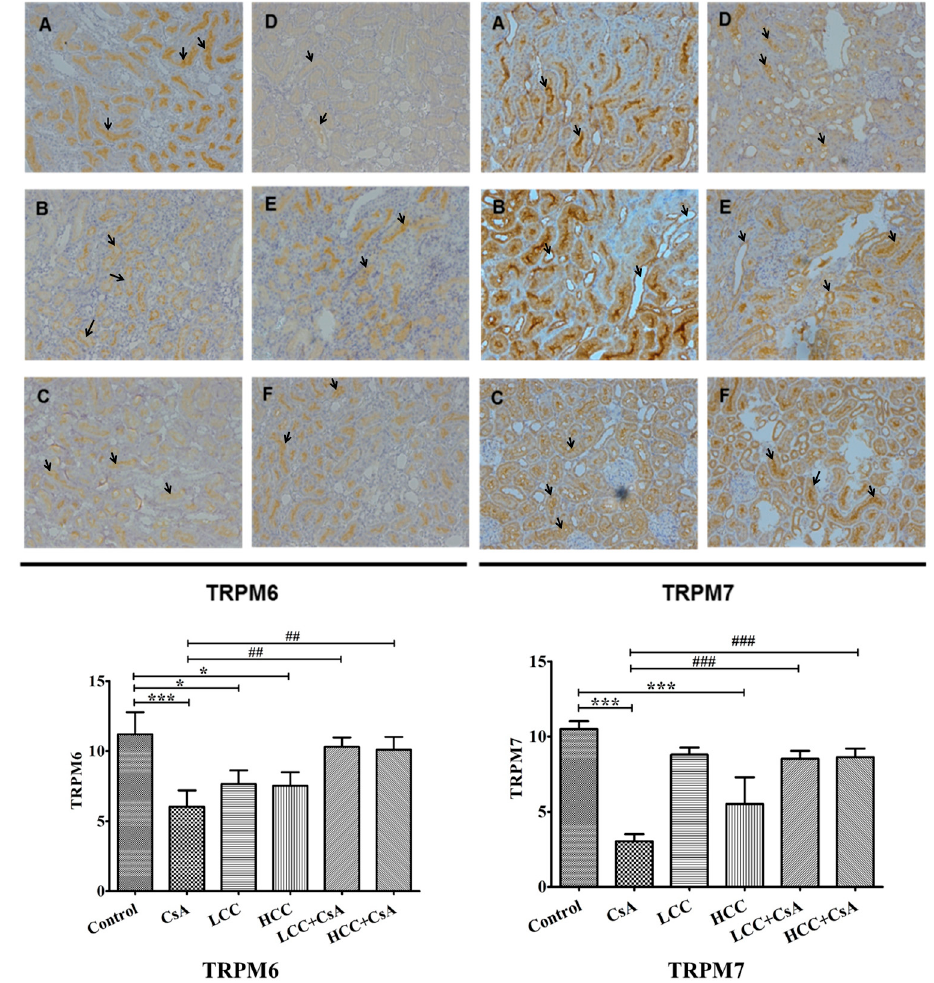
Figure 5. Representative immunohistochemistry (top panel) and quantitative analysis (bottom panel) of the levels of transient receptor potential melastatin 6 (TRPM6) and TRPM7 in rats treated with CCM and CsA. Arrows indicate the cells with the differences of TRPM6 and TRPM7 expres- sion among groups. Values are expressed as the mean ± SEM (n = 6). Control ( A ), CsA ( B ), LLC (40 mg/kg) ( C ), HCC (400 mg/kg) ( D ), LCC (40 mg/kg) + CsA ( E ), and HCC (400 mg/kg) + CsA ( F ). One-way ANOVA is followed by the Fisher’s LSD tests. * p < 0.05 and *** p < 0.001 vs. control. ## p < 0.01 and ### p < 0.001 vs. CsA group.